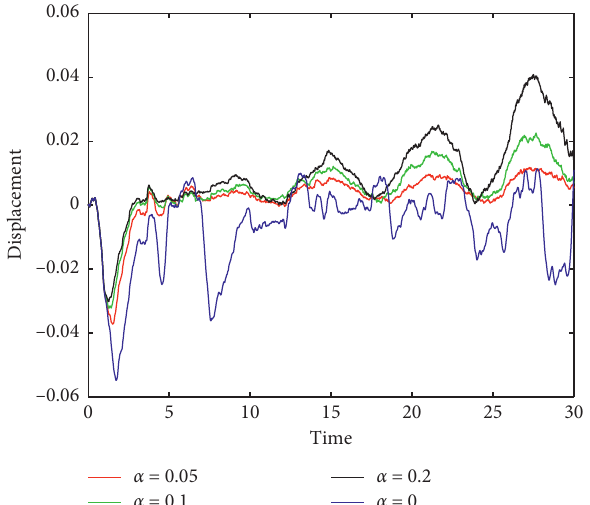
Figure 18: The horizontal displacement of 11 th story for the active system considering uncertainty with Δ � 1% and different values of α . –0.1–0.08–0.06–0.04–0.0200.020.040.060.080.1 d t 11 / d x